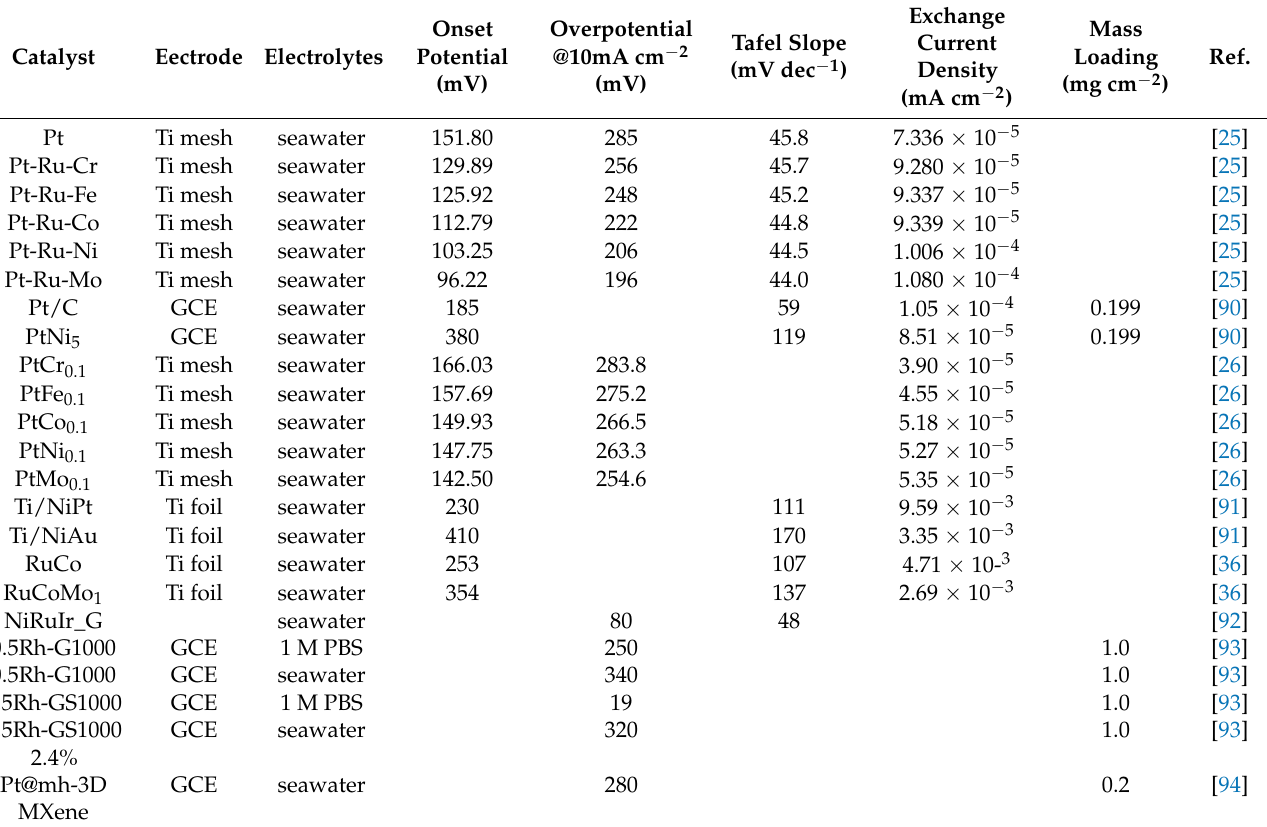
Table 2. Summary of HER performance of reported